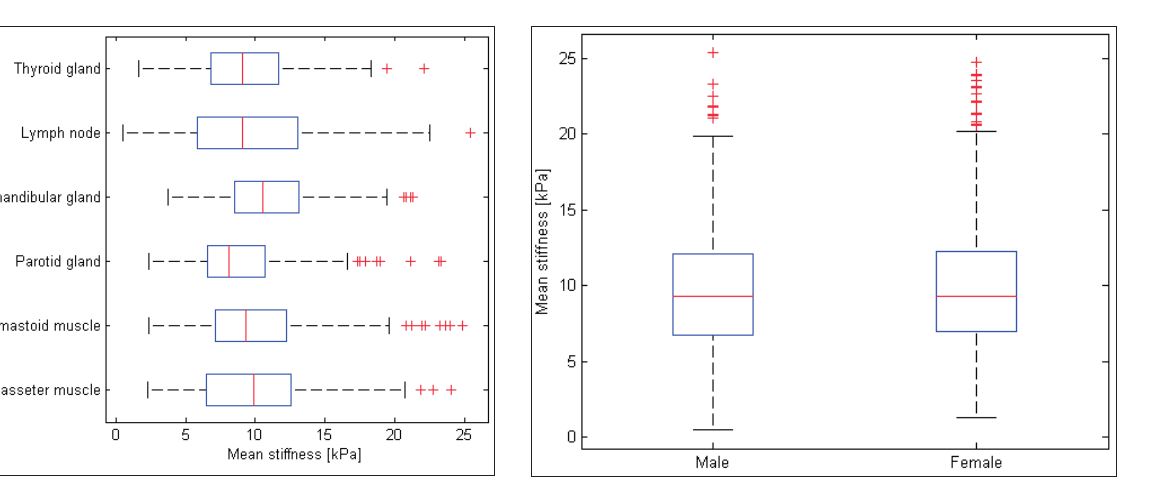
Fig. 1. Comparison of mean stiffness of individual organs. Fig. 2. Comparison of mean stiffness in all organs in males and females.